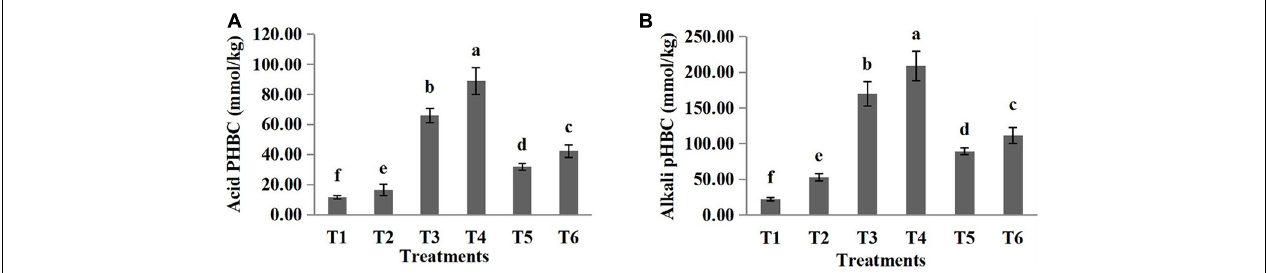
FIGURE 3 | Acid (A) and alkali (B) buffering capacity of different substrates. Bars represent standard errors. T1, sand; T2, sand + 1% HA; T3, cocopeat; T4, cocopeat + 1% HA; T5, 1:1 sand:cocopeat; T6, 1:1 sand:cocopeat + 1% HA. Different letters above the bars indicate significant differences at P < 0.05 according to Duncan’s multiple range test.